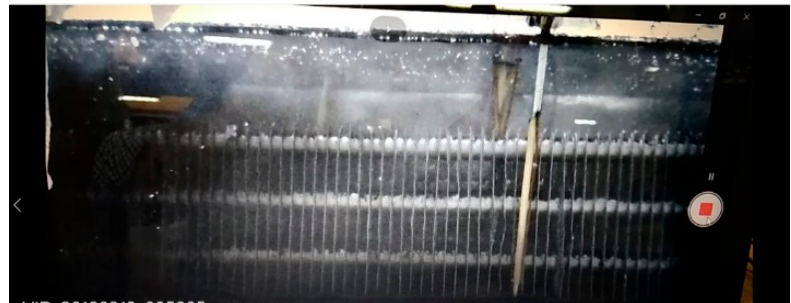
Figure 7. The interior of the tank filled with the PCM nanocomposite and the heat exchanger during the transducers’ operation. the transducers’